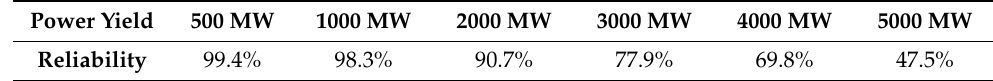
Table 3. The reliability of the power yield for the cascade. Power